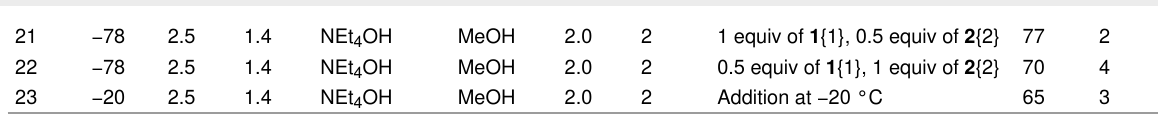
Table 2: Condensation trials between 1 {1} and phenylalanine amide ( 2 {2}). a (continued)